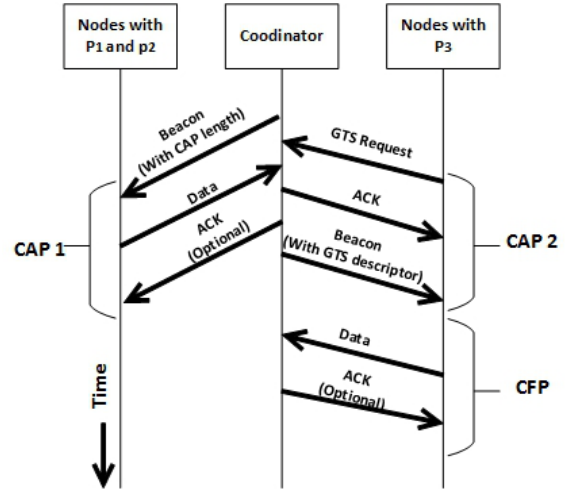
Figure 6. TAP-MAC data transfer. ACK: